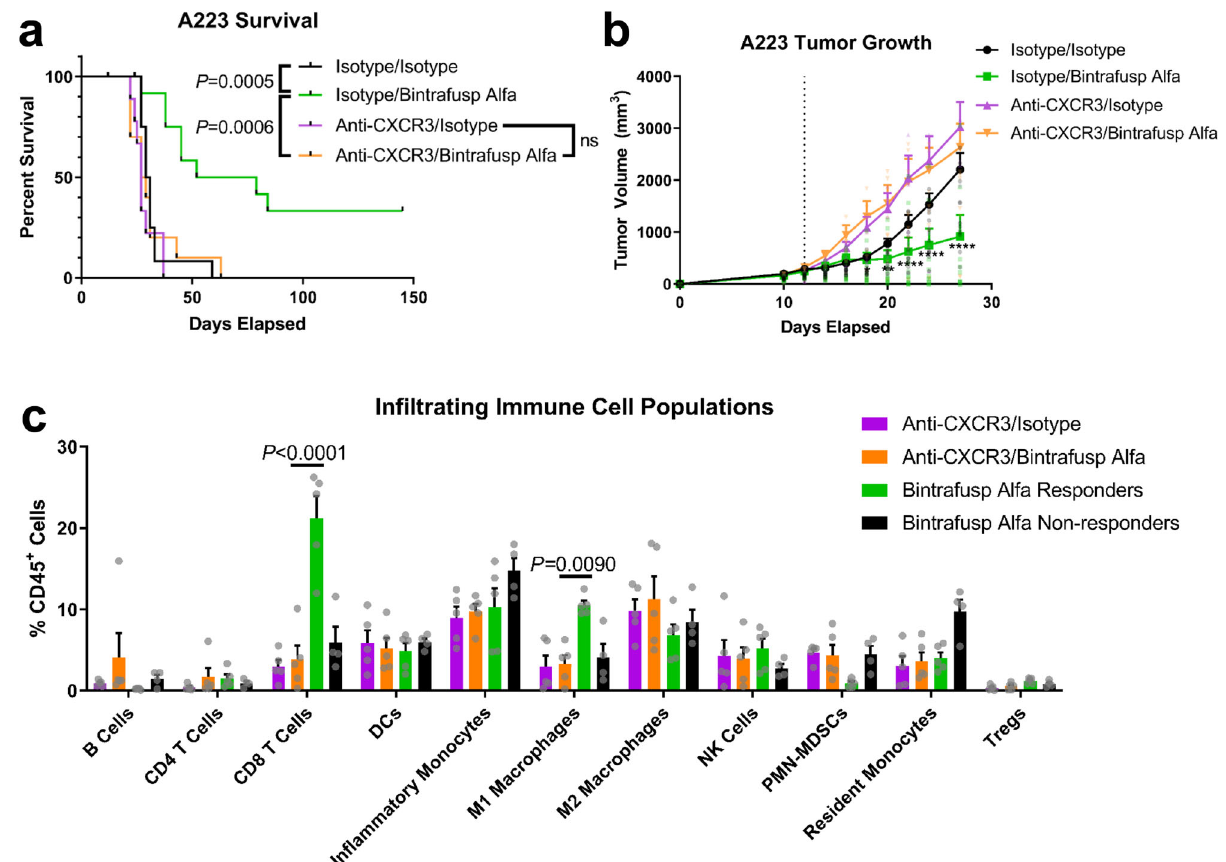
Fig. 7 Anti-CXCR3 abrogates the response to bintrafusp alfa in A223 tumors, resulting in tumors indistinguishable from nonresponders to bintrafusp alfa. a Survival post-injection of C57BL/6 mice bearing A223 tumors that were treated with double isotype controls (black line, n = 12), isotype and bintrafusp alfa (green line, n = 13), anti-CXCR3 and isotype control (purple line, n = 9), or anti-CXCR3 and bintrafusp alfa (orange line, n = 10). b Tumor growth in mice treated from ( a ). Survival comparisons were performed using the log-rank Mantel – Cox test. Differences between isotype/bintrafusp alfa (green) and anti-CXCR3/bintrafusp alfa (orange) in ( b ) were identi fi ed by two-way ANOVA ( P < 0.0001, F = 3.848, df = 27) with multiple comparisons corrected by Tukey ’ s method and indicated by * for P = 0.0328, ** for P = 0.0028, and **** for P < 0.0001. c In fi ltrating immune cell populations of mice treated with anti-CXCR3 in combination with bintrafusp alfa (orange bars, n = 5) or its isotype control (purple bars, n = 5); mice were also treated with bintrafusp alfa alone and separated into nonresponders (black bars, n = 4) and responders (green bars, n = 5). Total population differences were determined by two-way ANOVA ( P < 0.0001, F = 5.979, df = 30) and Sidak ’ s multiple comparisons test with signi fi cantly altered populations between bintrafusp alfa responders (green) and anti-CXCR3 in combination with bintrafusp alfa (orange) are shown. Survival comparisons in ( a ) were performed using the log-rank Mantel – Cox test, and all error bars represent the